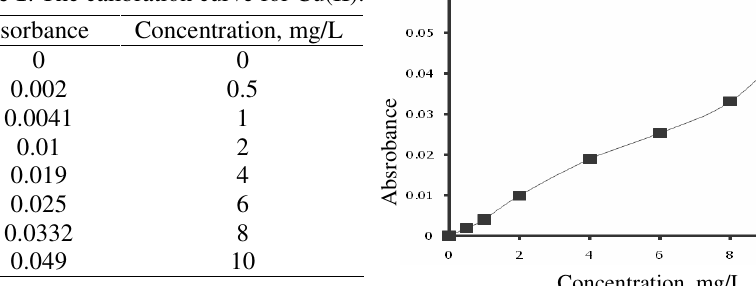
Figure 1. The calibration curve for